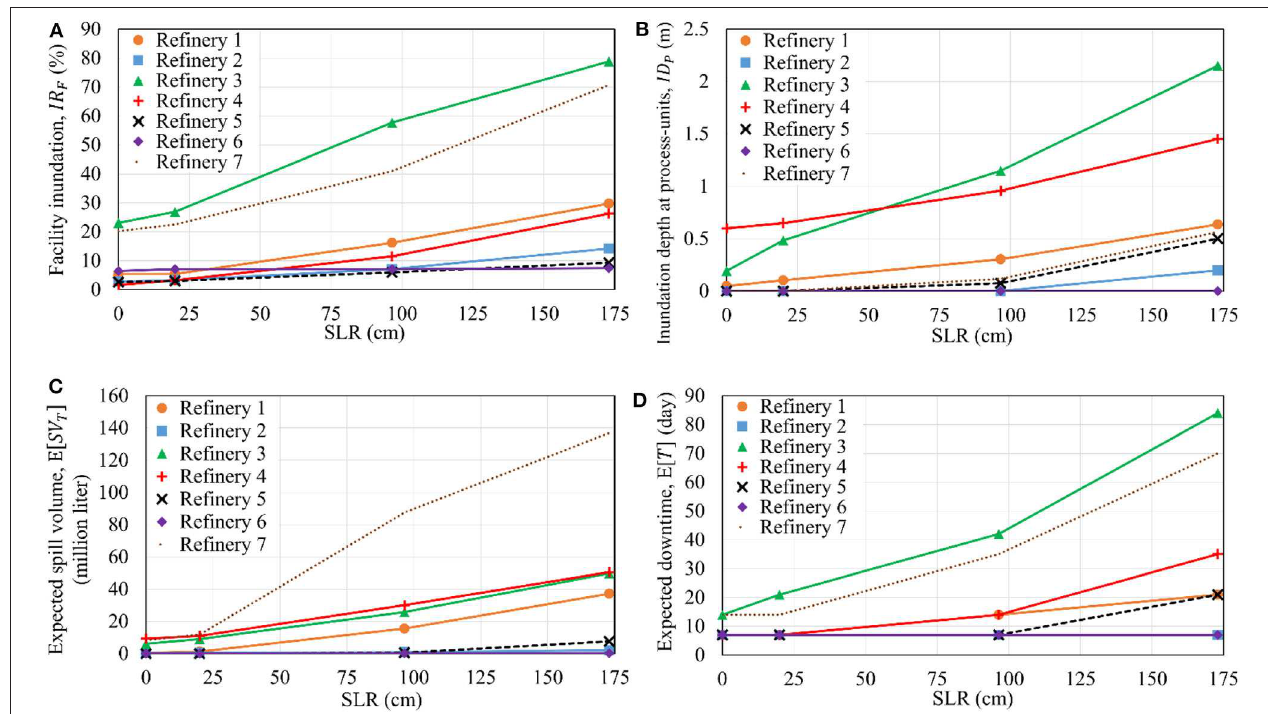
FIGURE 8 | Effect of SLR of FEMA 33 (original forward speed, i.e., 5.6 m/s) on the intermediate parameters used in the loss analysis. (A) Facility inundation, (B) Process-units inundation, (C) Spill volume, (D) Refinery